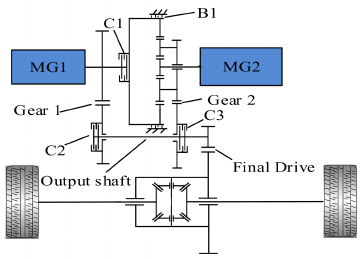
Figure 1. The structure of novel dual-motor coupling-propulsion powertrain system (NDMPS).